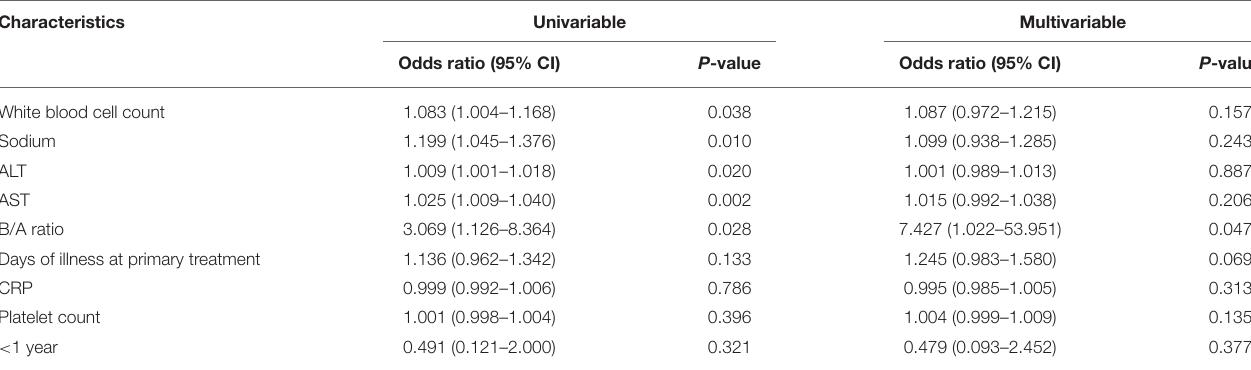
TABLE 2 | Results of logistic regression analyses of intravenous immunoglobulin resistance.